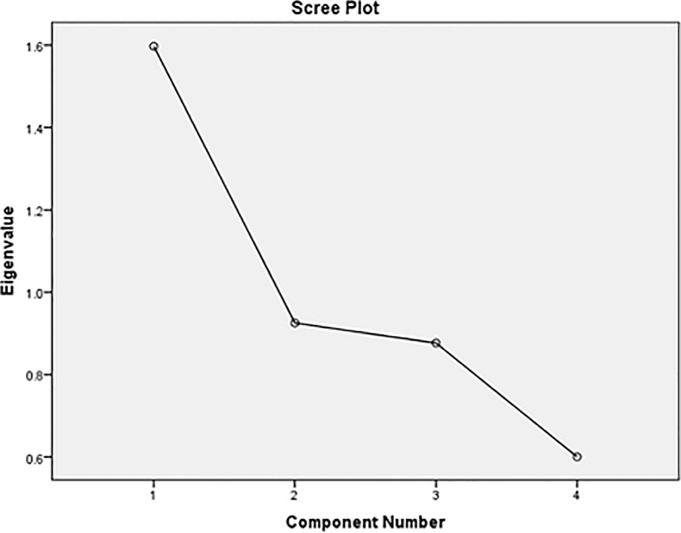
Scree plot for cognitive general factor scores.